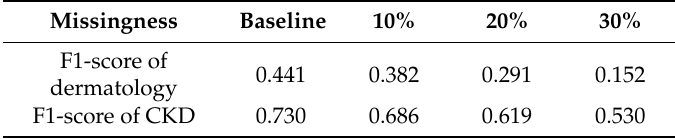
Table 4. Results of restricted Boltzmann machine (RBM)-based model for each